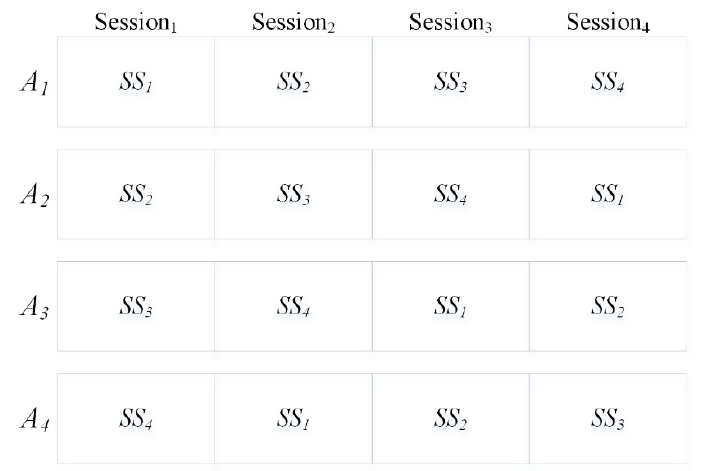
Figure 5. Scheduling process in the logical schedule based authentication (LSA) scheme.